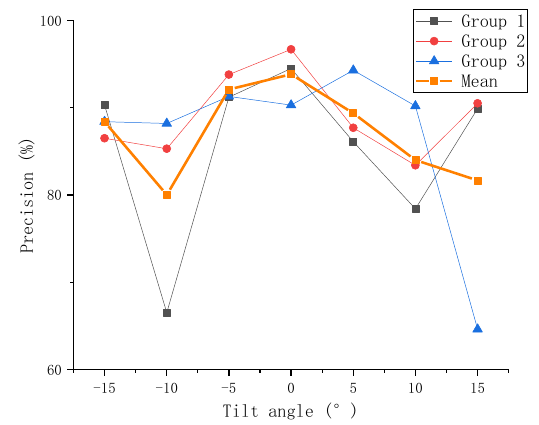
Figure 24. Precision of test samples with different tilt angles.